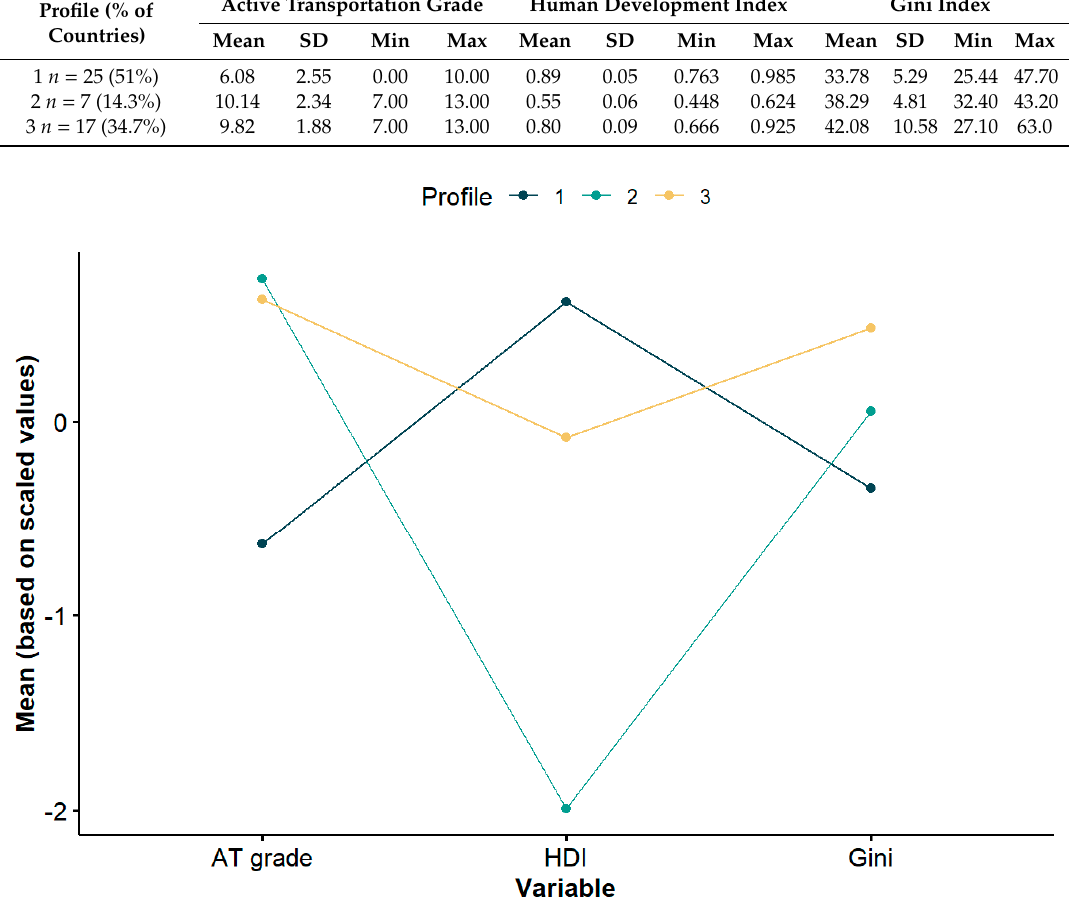
Figure 1. Country profiles for active transportation and sociodemographic variables of countries in the Global Matrix 3.0. The range of values for the active transportation grade, Human Development Index and the Gini index varied notably between variables, therefore they were converted to z-scores to be expressed in the same range of values and to ease their graphic depiction.